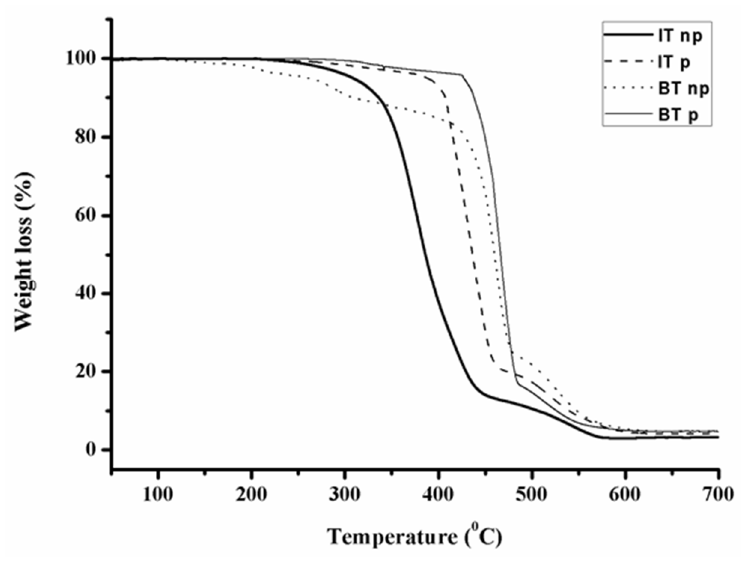
Figure 5. TGA thermographs of all the synthesized hybrid materials.